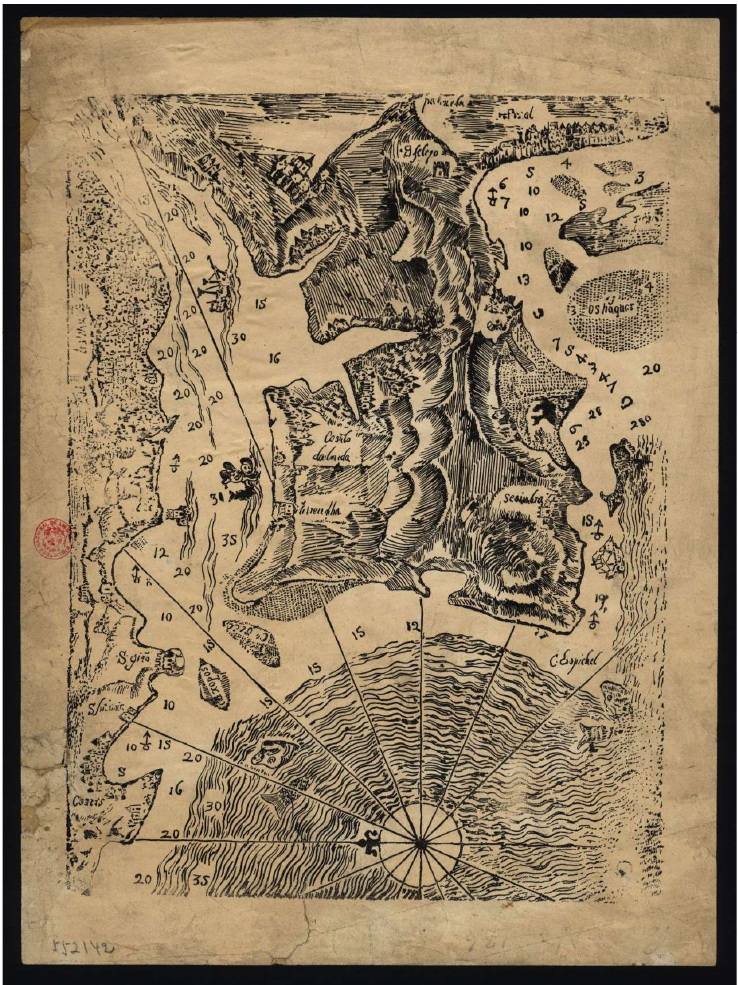
Figure 3. A map of the seaports of Lisbon and Setúbal, by António de Mariz Carneiro (15--/1642); from BND—Portuguese National Library Digital Collections (http://purl.pt/1549). In the upper part of